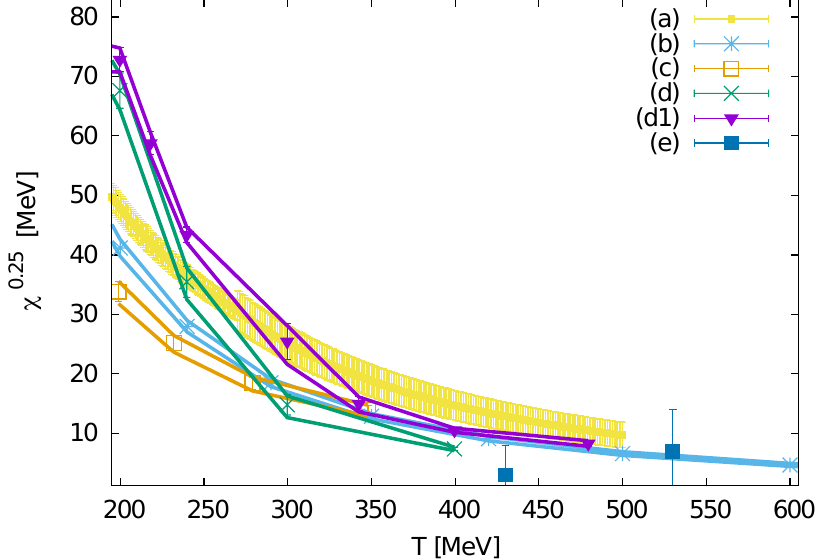
Figure 2. The fourth root of topological susceptibility versus the temperature in full QCD. (a) shows the gluonic results from Ref. [21]. (b) shows the tabulated results from Ref. [23]. (c) Ref. [24]; these results are rescaled from a higher pion mass (d) and (d1) show the results from Ref. [22] obtained by rescaling from the two lightest masses m π = 220, 260 MeV. (e) the results from Ref. [20], where a careful continuum extrapolation with a conservative error estimate was performed. From Ref.